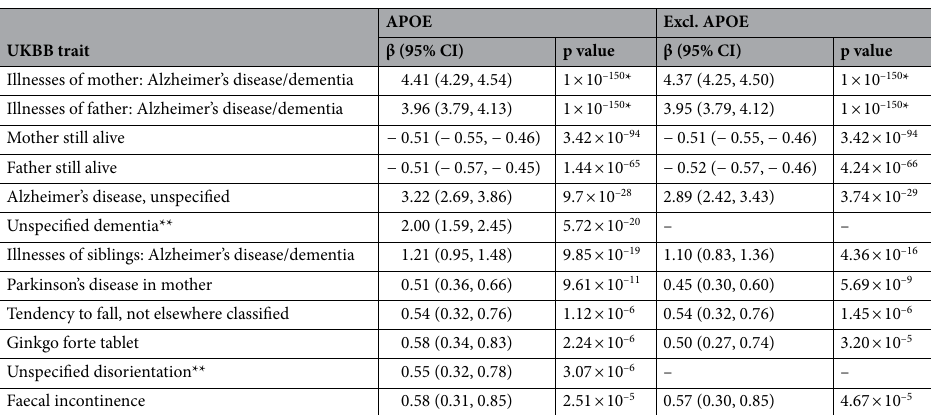
Table 3. PheWAS results for AD PRS extremes. Shown are results with adjusted p value ≤ 4.3 × 10 –5 and β ≥ |0.5|. APOE indicates the PheWAS using individuals from the PRS extremes when APOE was included; Excl. APOE indicates PheWAS using individuals in the PRS extremes when the APOE locus was excluded from the PRS analysis (see “Methods”). * p value was too significant, and software output was zero—to plot these values (Fig. 6), we attributed a p value of 1 × 10 –150 . **Traits were excluded from PheWAS analysis using individuals from the PRS calculated without APOE due to lack of